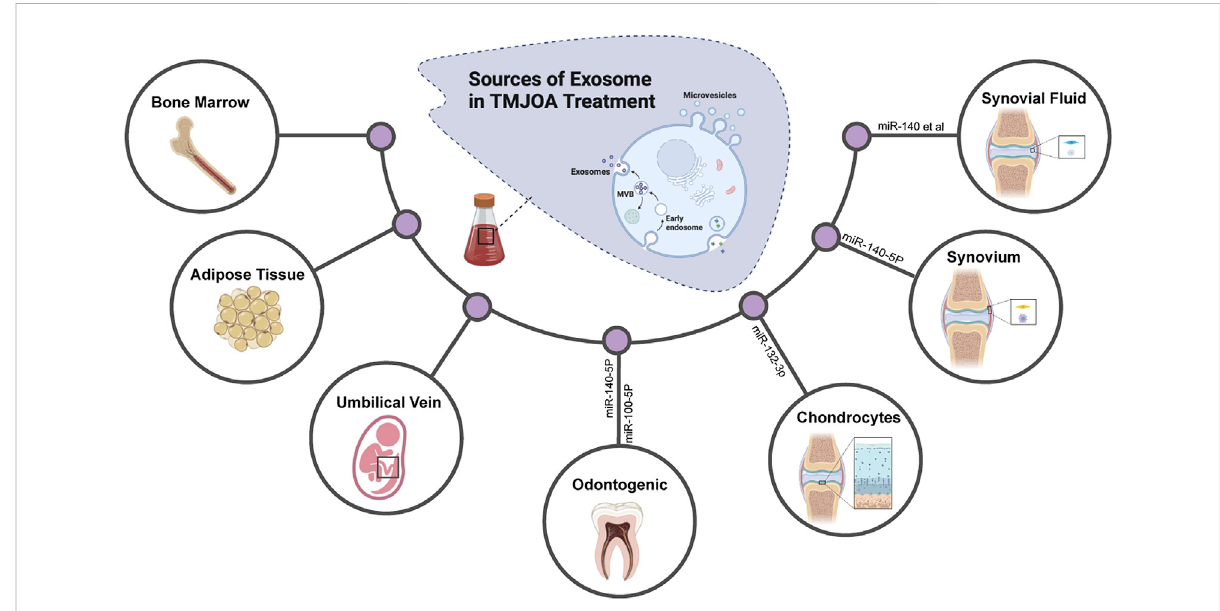
FIGURE 3 Exosomes derived from different tissues and cells are applied for TMJOA treatment. Diversi fi ed exosomes are obtained and applied in OA treatment to have a deeper understanding of the occurrence, development of OA, and to fi nd more novel targets in molecular mechanisms of TMJOA